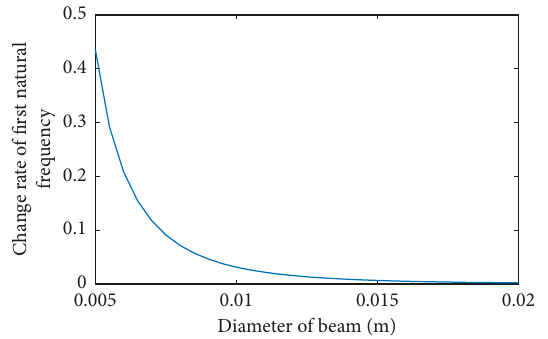
Figure 9: Change rate of first natural frequency at different diameters. Table 4: Processing parameters of the process. Spindle